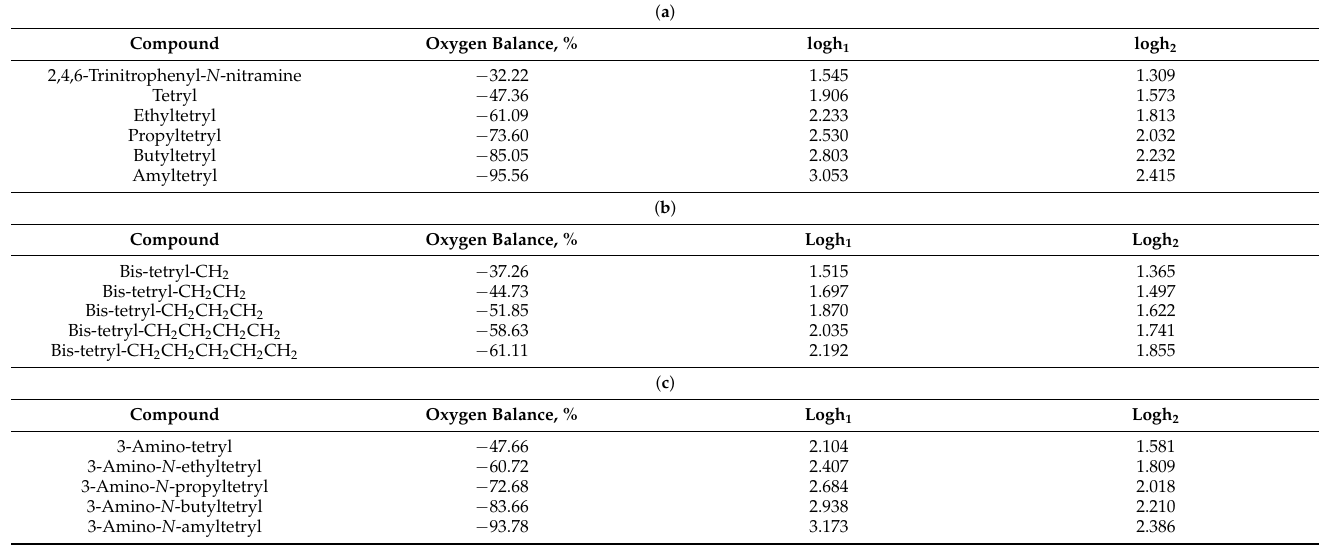
Table 2. The parameters describing the resistance to the impact of the compounds belonging ( a ) Ho- mologous aromatic N-nitramines, tetryl derivatives [(2,4,6-trinitrophenyl-(O 2 N)N(CH 2 ) n H, n = 0–5]. ( b ) Bis-aromatic homologs of chain length variation (CH 2 ) n of [(2,4,6-trinitrophenyl-N(NO 2 )] 2 (CH 2 ) n , ( n = 1–5)]. ( c ) 3-Amino derivatives of tetryl with chain length variation [(3-amino-2,4,6-trinitrophenyl- (O 2 N)N(CH 2 ) n H, n = 1–5] homologs. The results are discussed in the next section of this